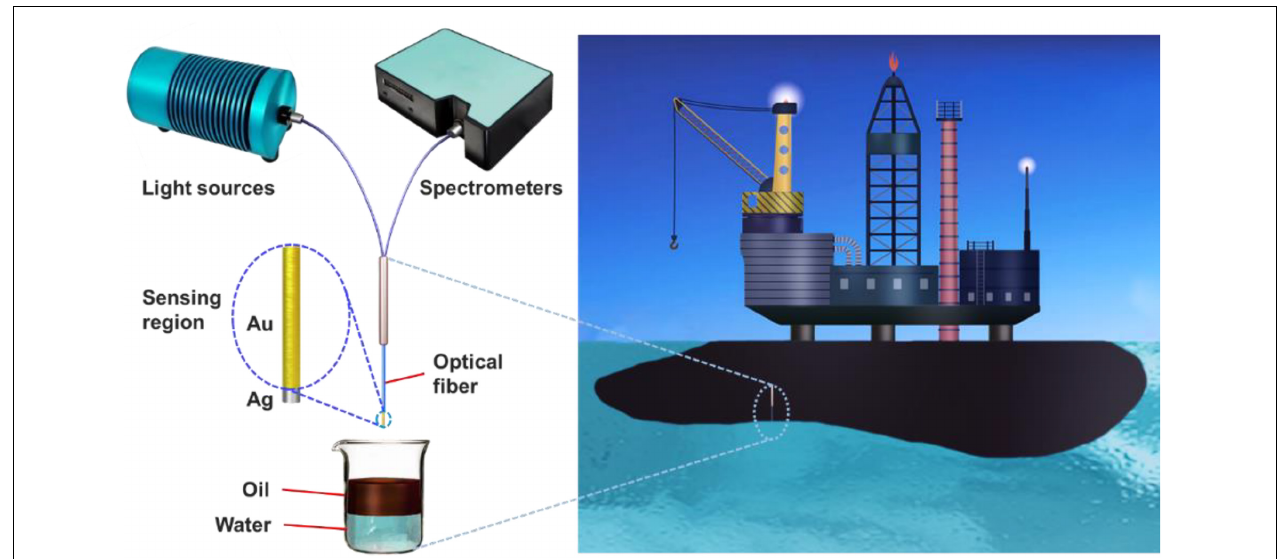
FIGURE 1 | Schematic diagram of oil slick thickness measurements by fiber-optic surface plasmon resonance (FOSPR)